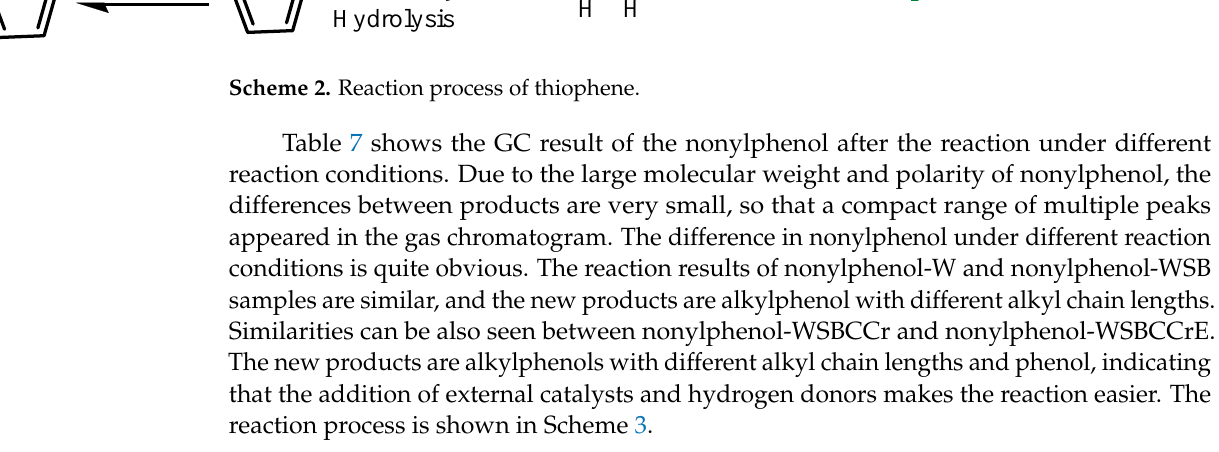
Table 7. The new compounds of nonylphenol under different reaction conditions.